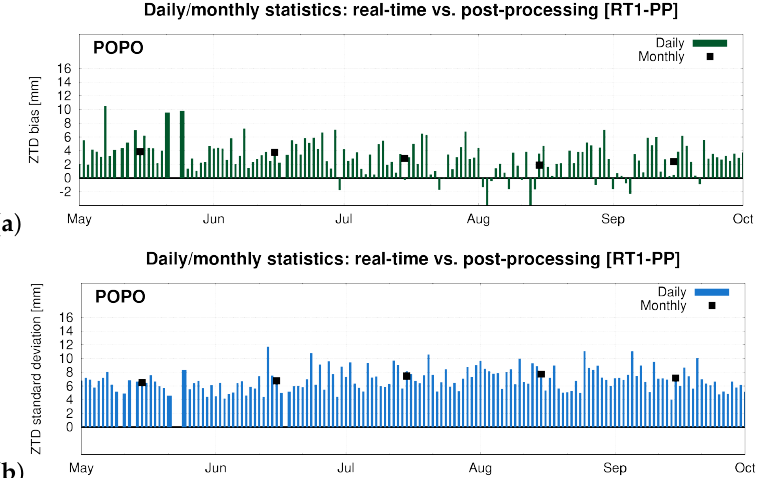
Figure 2. Daily statistics for May–September, 2021 of the ZTD comparisons (real–time minus post–processing) for station Popovitsa (POPO); ( a ) systematic error and ( b ) standard deviation.